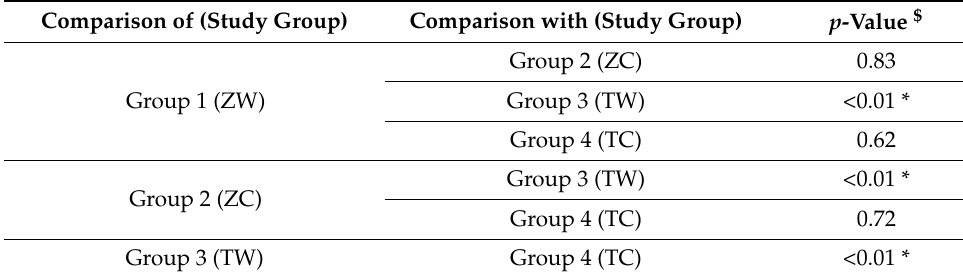
Table 8. Individual group (inter-group) comparison of post-treatment surface gloss among study